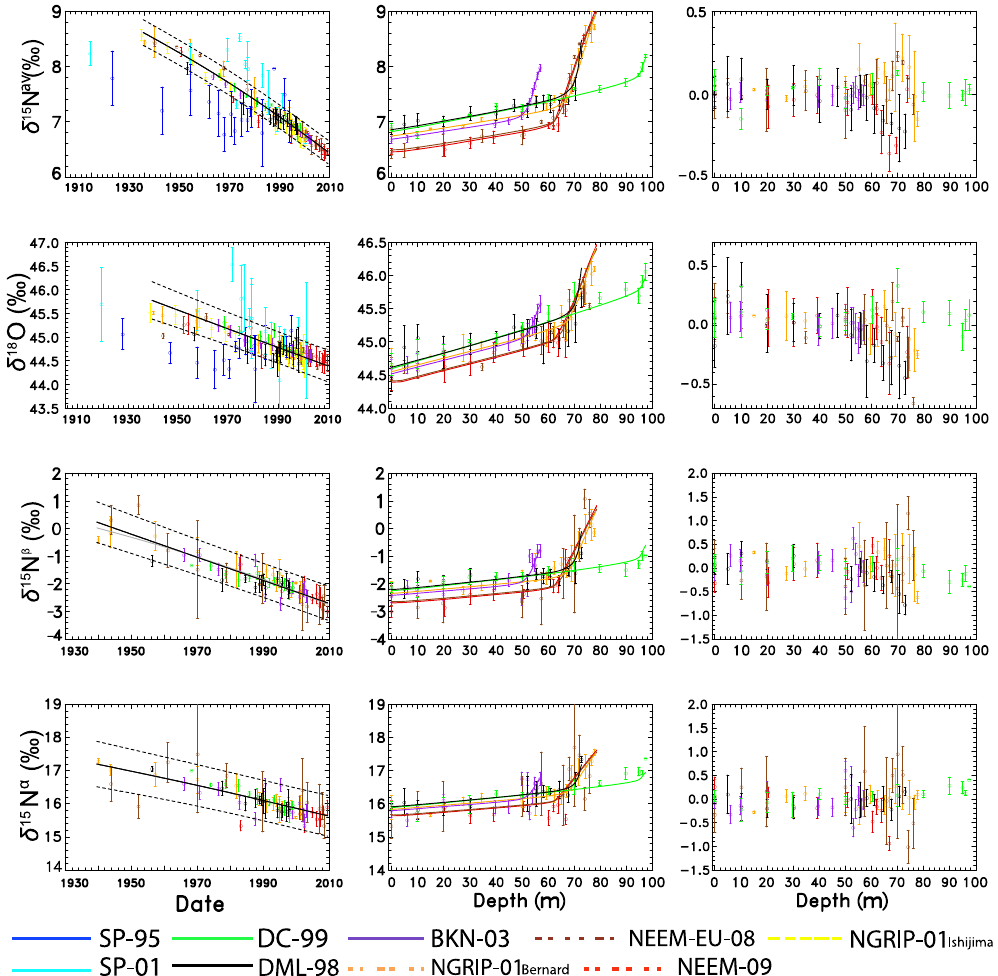
Figure C3. Sensitivity test to the regularization term increased by a factor of 10. Reconstructed atmospheric scenarios (left), corresponding fit of the firn data (center), and model data discrepancies (right). The best reconstructed scenarios are shown as the black continuous lines, with model-derived uncertainties (2 σ ) in dashed lines. Colors as in Fig.